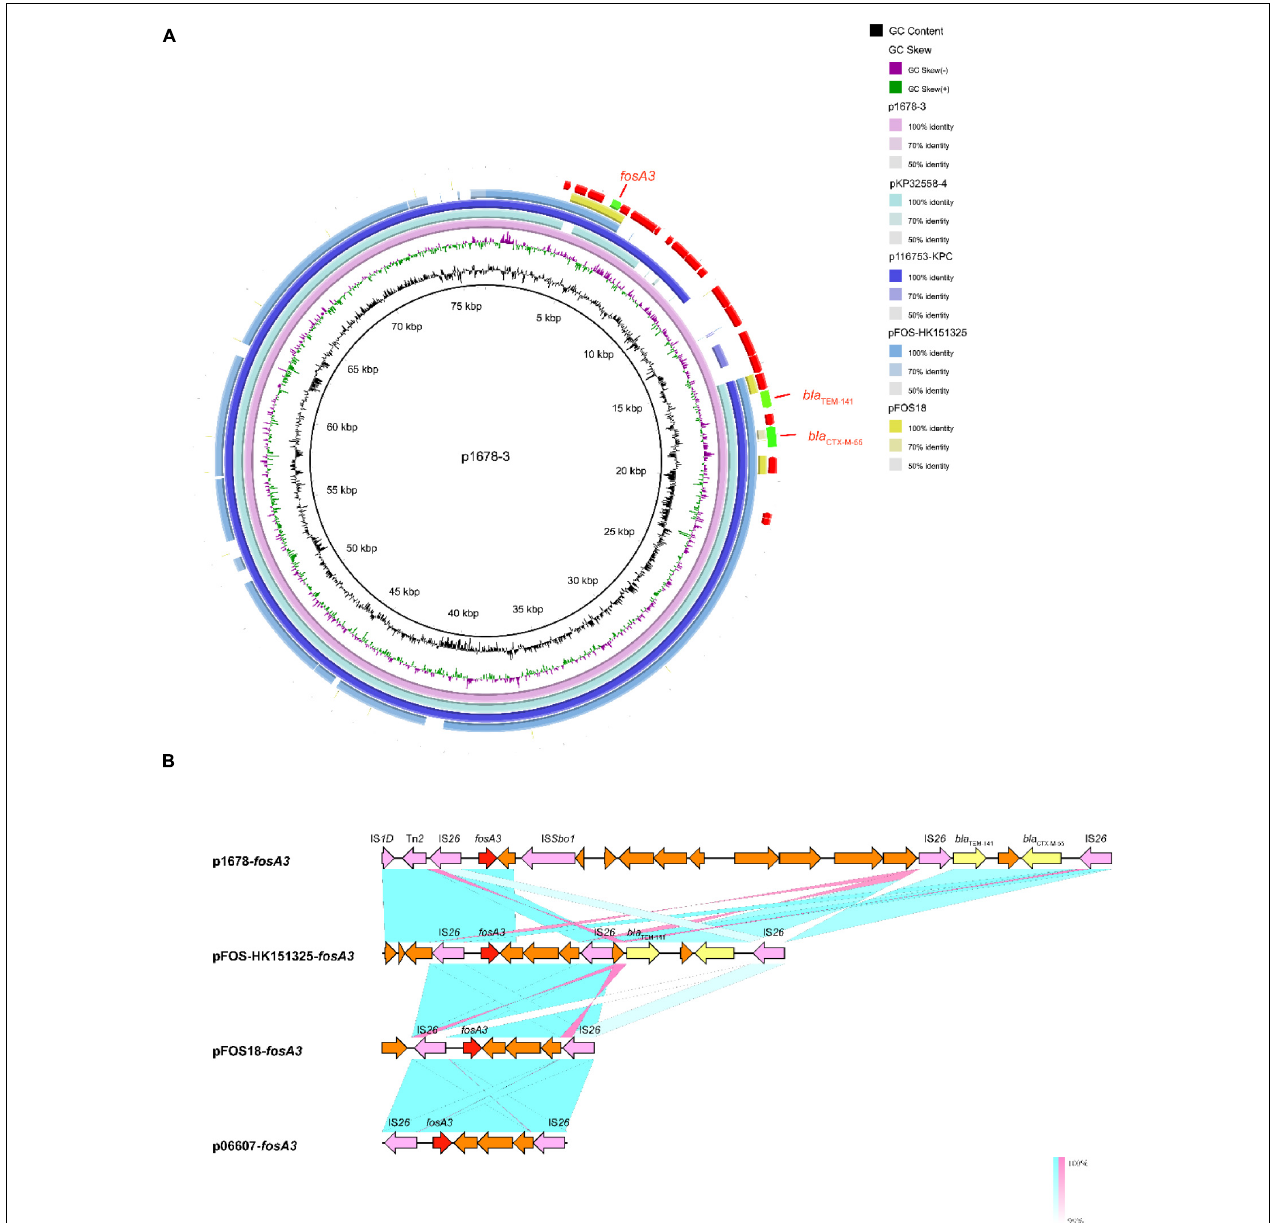
FIGURE 3 | Comparative analysis of pl687-3 plasmids with other reference plasmids. (A) p1678-3 (CP080447) was used as the reference plasmid to perform genome alignment with pFOS-HK151325 (JX627737, first fosA3 plasmid from a clinical E. coli identified in China) and pFOS18 (KJ653815, first fosA3 plasmid from a clinical K. pneumoniae identified in China). Moreover, p1678-3 was also compared with another two similar plasmids pKP32558-4 (CP076034.1, K. pneumoniae ) and p116753-KPC (MN891682.1, K. pneumoniae ). The red arrows represent CDs. (B) Linear comparison of the fosA3 region. The fosA3 region was compared with the regions extracted from pFOS-HK151325, pFOS18, and p06607 (AB522970, first fosA3